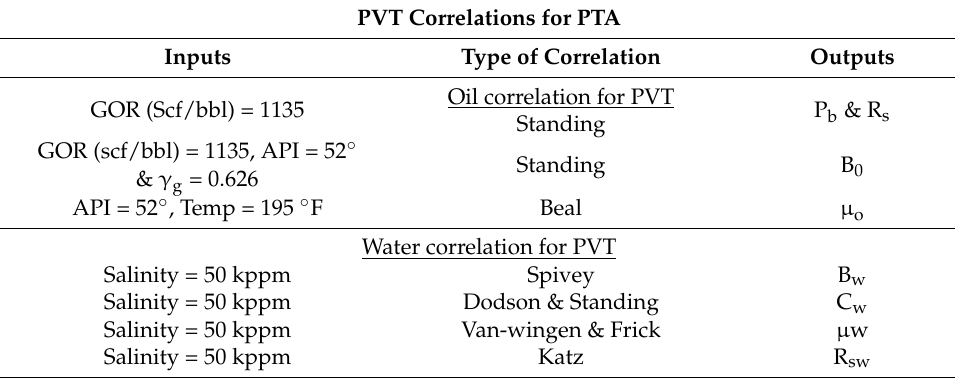
Table 2. The PVT correlations used for well ND-1. PVT Correlations for PTA Inputs Type of Correlation Outputs Oil correlation for PVT GOR (Scf/bbl) = 1135 Standing